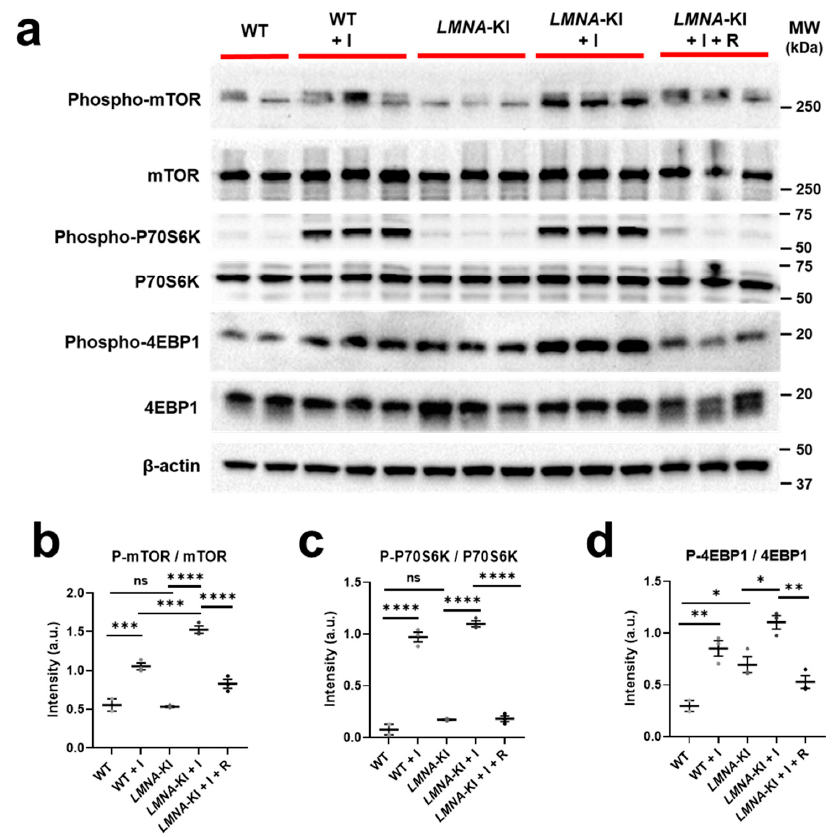
Figure 3. Expression of proteins of the mTOR signaling pathway with and without isoprenaline stimulation. WT and LMNA -KI mES cells were differentiated into cardiomyocytes and stimulated on day 12 with either isoprenaline (I) or isoprenaline together with rapamycin (R). ( a ) Western blot images of total and phosphorylated protein levels of mTOR, P70S6K, and 4EBP1. β -actin is used as a loading control. ( b – d ) Densitometric quantification of phosphorylated protein relative to total protein, measured by ImageJ program. One-way ANOVA and Tukey’s post hoc analysis were used. Data are shown as mean ± SEM ( n = 2–3). **** p < 0.0001, *** p < 0.001, ** p < 0.01, * p < 0.05. I = isoprenaline, R =